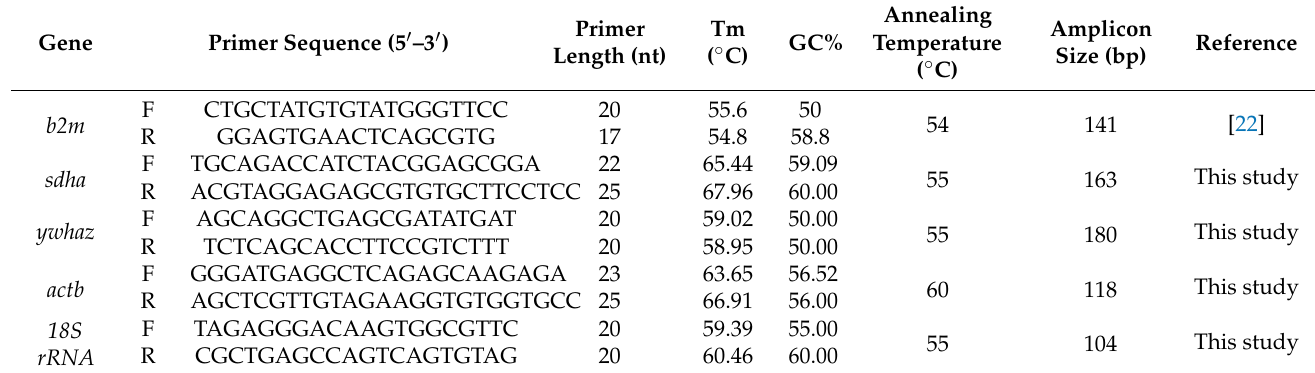
Table 1. Primers of candidate reference